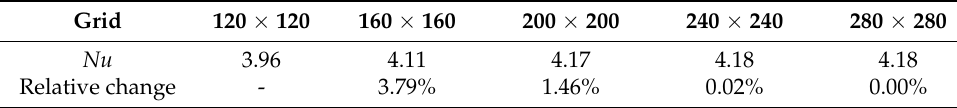
Table 2. Effect of the grid size on the average Nusselt